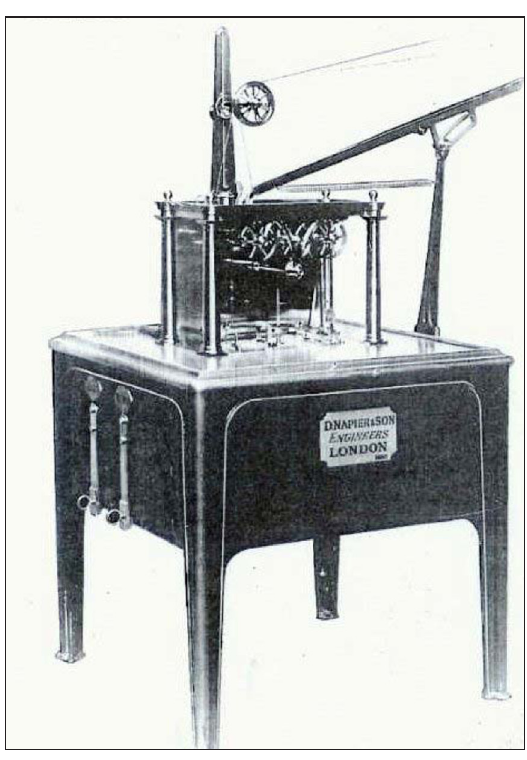
Fig. 1 : Napier & Son, ‘Automaton’ coin weighing machine for the Bank of England, 1842. Image taken from <http://www.enginehistory.org/members/ Convention/2011/Presentations/NapierHx1178-1930.pdf.> [accessed 10 February